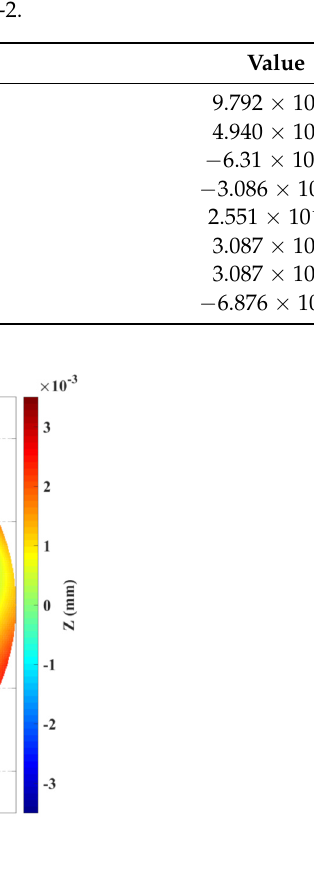
Figure 6. Design of the proposed thermo-invariant material measure for freeform surface TIMM-2 with application in industry.